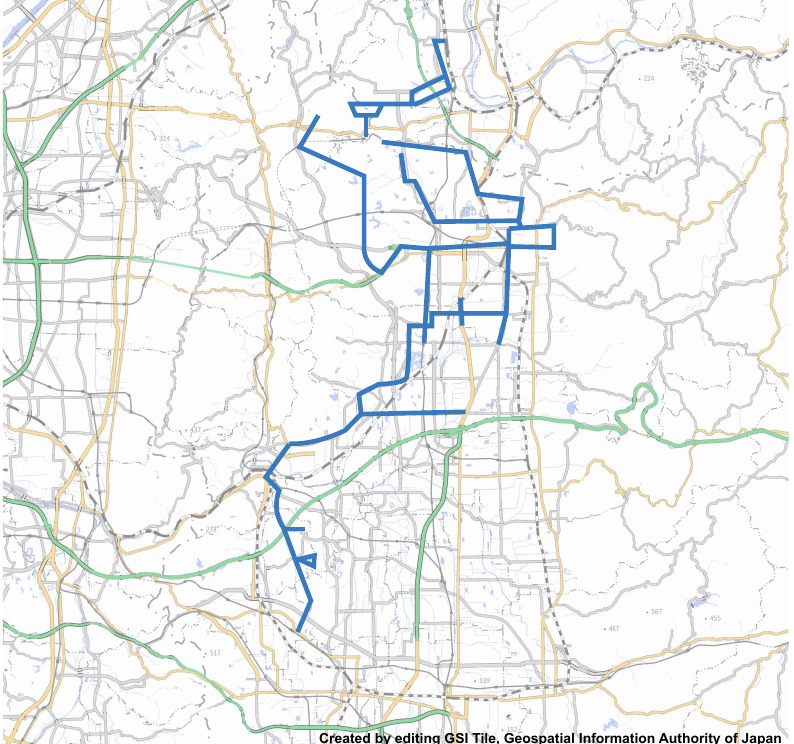
Figure 5. The data collection